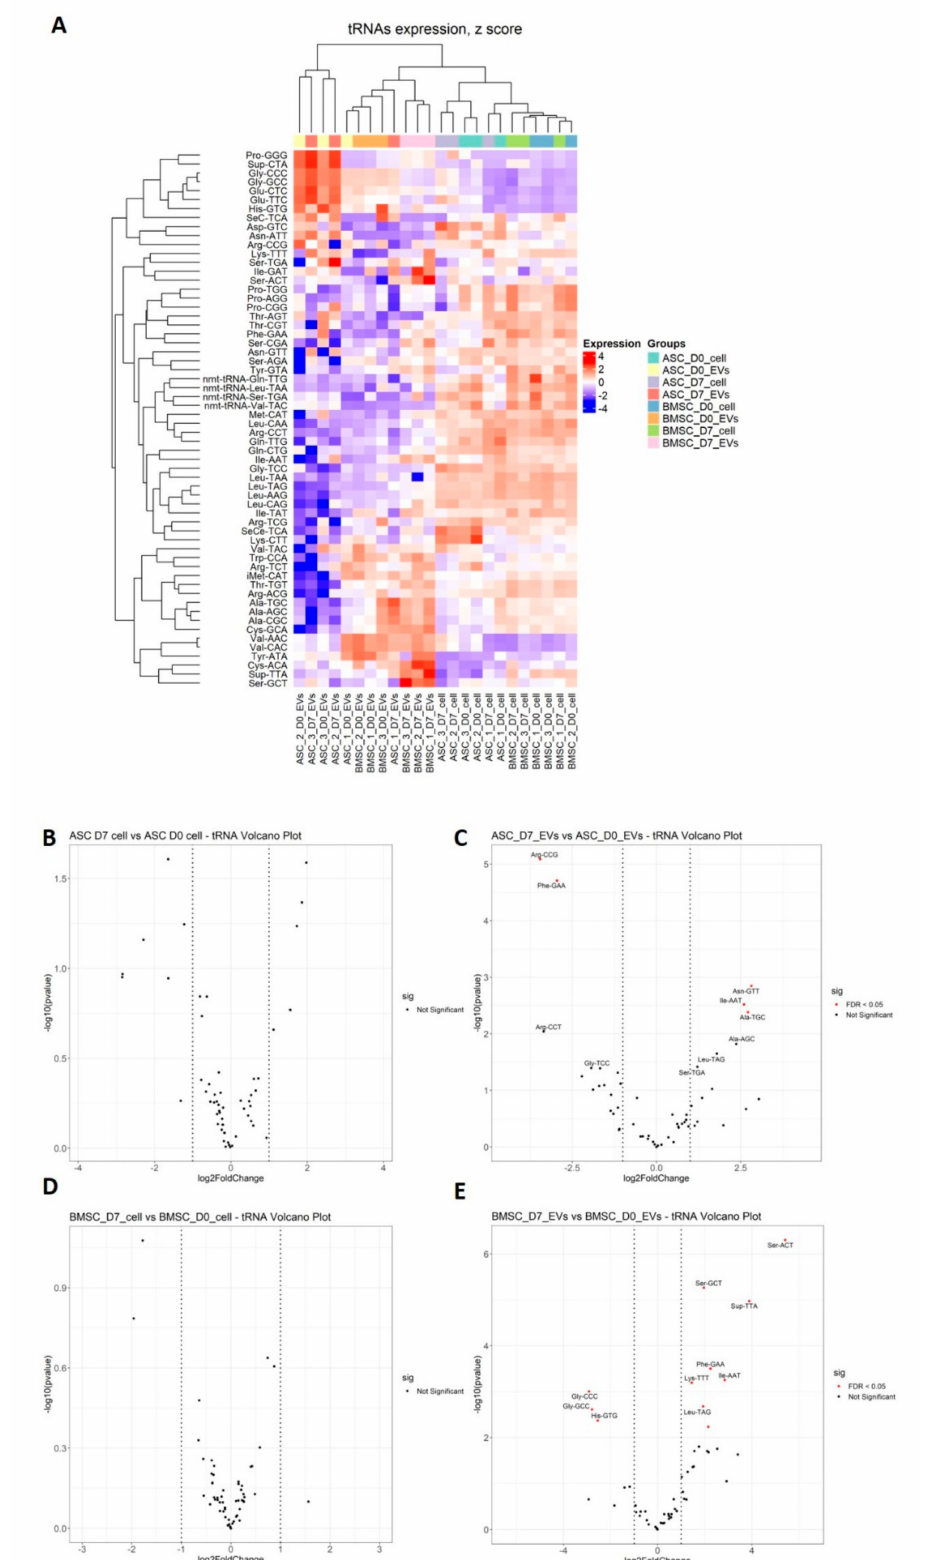
Figure 6. Di ff erential expression analysis of tsRNAs in MSCs and MSC-EVs. ( A ) Heat map shows the expression profile of tsRNAs with unsupervised clustering of sample origin ( B ) Di ff erential expression analysis of tsRNAs using DESeq2. The miRNAs with Abs (log2FoldChange) ≥ 1 and FDR < 0.05 are deemed as significantly changed and marked in red in the volcano